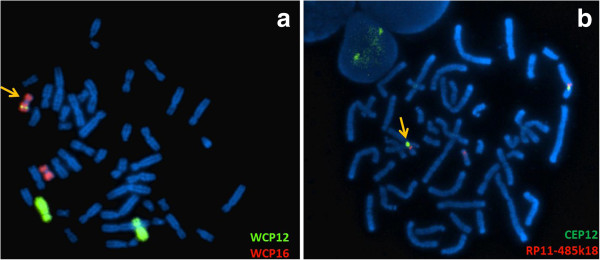
Dual colour fluorescence in situ hybridization analysis of chromosome 16 and chromosome 12. FISH analysis using wcp12 (green) and wcp16 (red) probes (a) or RP11-485K18 (red) BAC probe, mapping to 12p11.2 and CEP12 (green), used as control probe (b), showed that the additional material present in the q arm of one chromosome 16 was derived from chromosome 12 and confirmed the pericentric inversion of one chromosome 12.